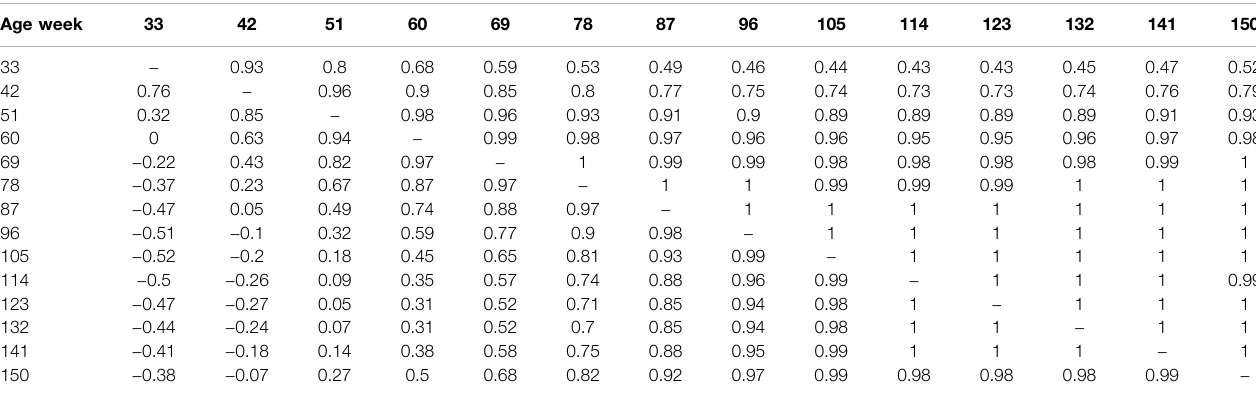
TABLE 5 | Genetic correlations between sperm motility of all ages, estimated with a random regression